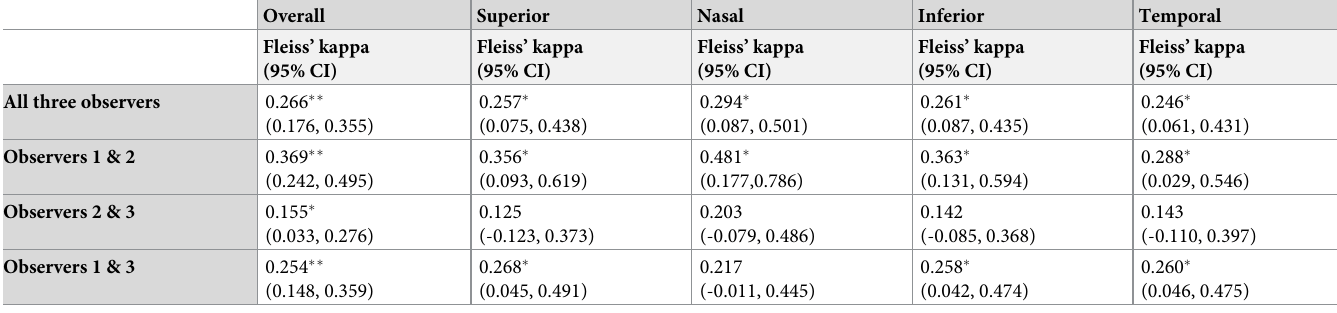
Table 2. Interobserver agreement of shaffer angle width grading in the analysis of NIDEK GS-1 goniophotography.